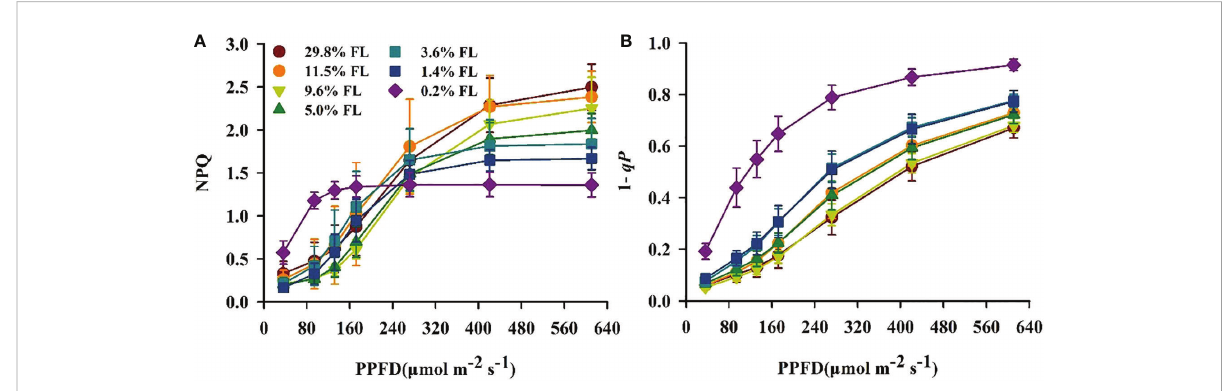
FIGURE 6 Changes of fl uorescence characteristics in the light response process in P. notoginseng under different levels of light. (A) NPQ is the non- photochemical quenching of PSII. (B) 1- qP is the light response changes in the redox poise of the primary electron acceptor of PSII. Values for each point were means ± SD ( n = 7).